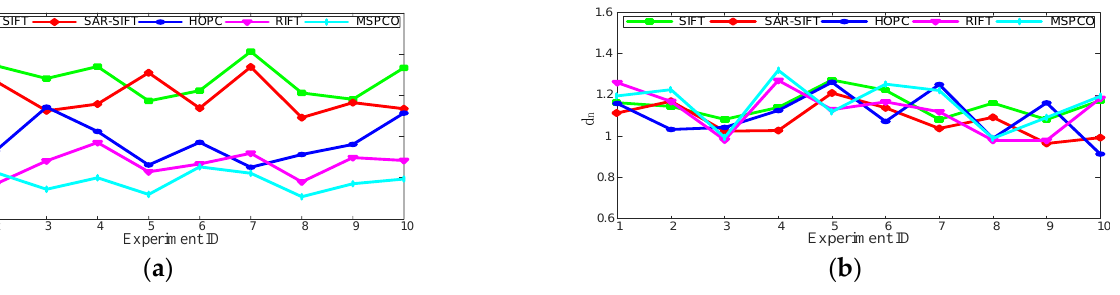
Figure 9. Robustness and uniqueness analysis of the descriptors: ( a ) Robustness analysis; ( b ) Unique- ness analysis.